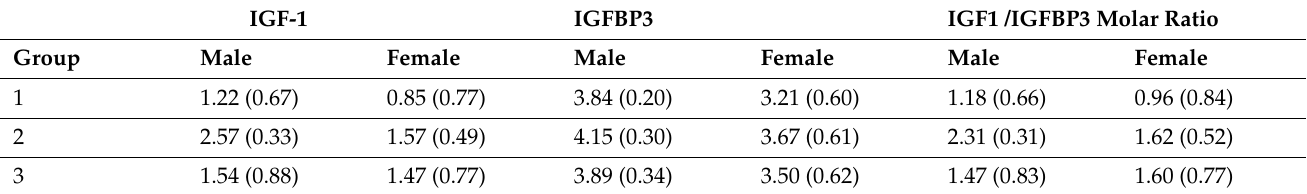
Table 3. Mean (SD) of IGF-1, IGFBP3, and the IGF-1/IGFBP3 ratio based on groups and gender.